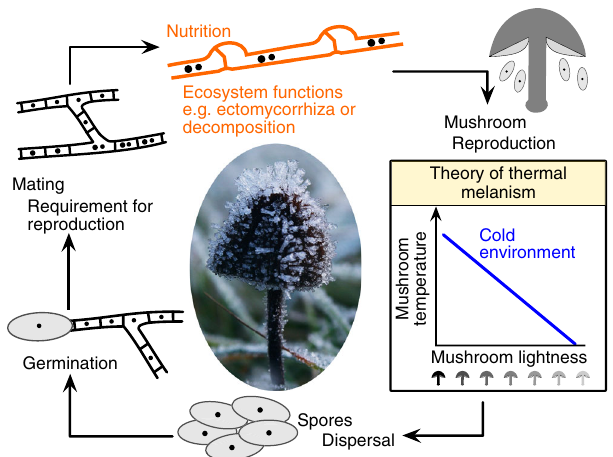
Fig. 1 The theory of thermal melanism for multicellular mushroom-forming fungi. The theory predicts that dark-colored mushrooms heat up more rapidly than light-colored mushrooms and, therefore, have advantages, such as increased reproductive success, in cold environments. Mushroom photo taken from http://www.peakpx.com/556831/brown-mushroom- illustration was drawn by Franz-S. Krah using the program Af fi nity